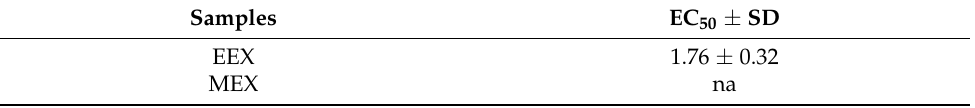
Table 8. Cytotoxic activity of EEX and MEX on HL60 cell line for 72 h. Samples